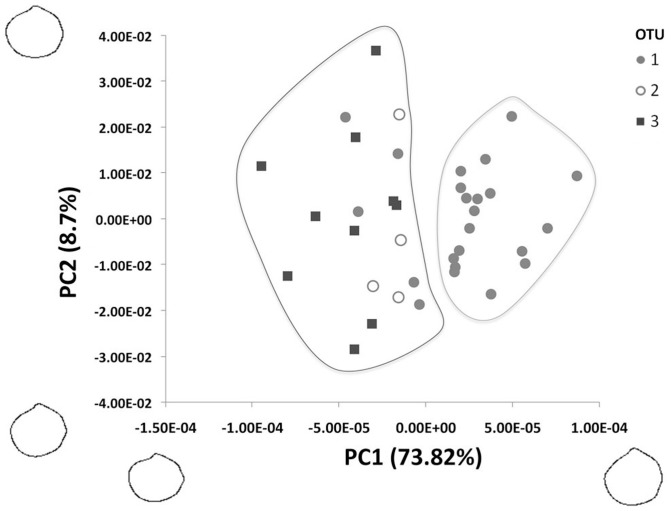
Shape variation among shells along the first two principal components.Reconstructed contours show shapes at the extremities of each axis. Symbols refer to operational taxonomic groups (OTUs) based on CO1, 18S and 28S rRNA sequences.